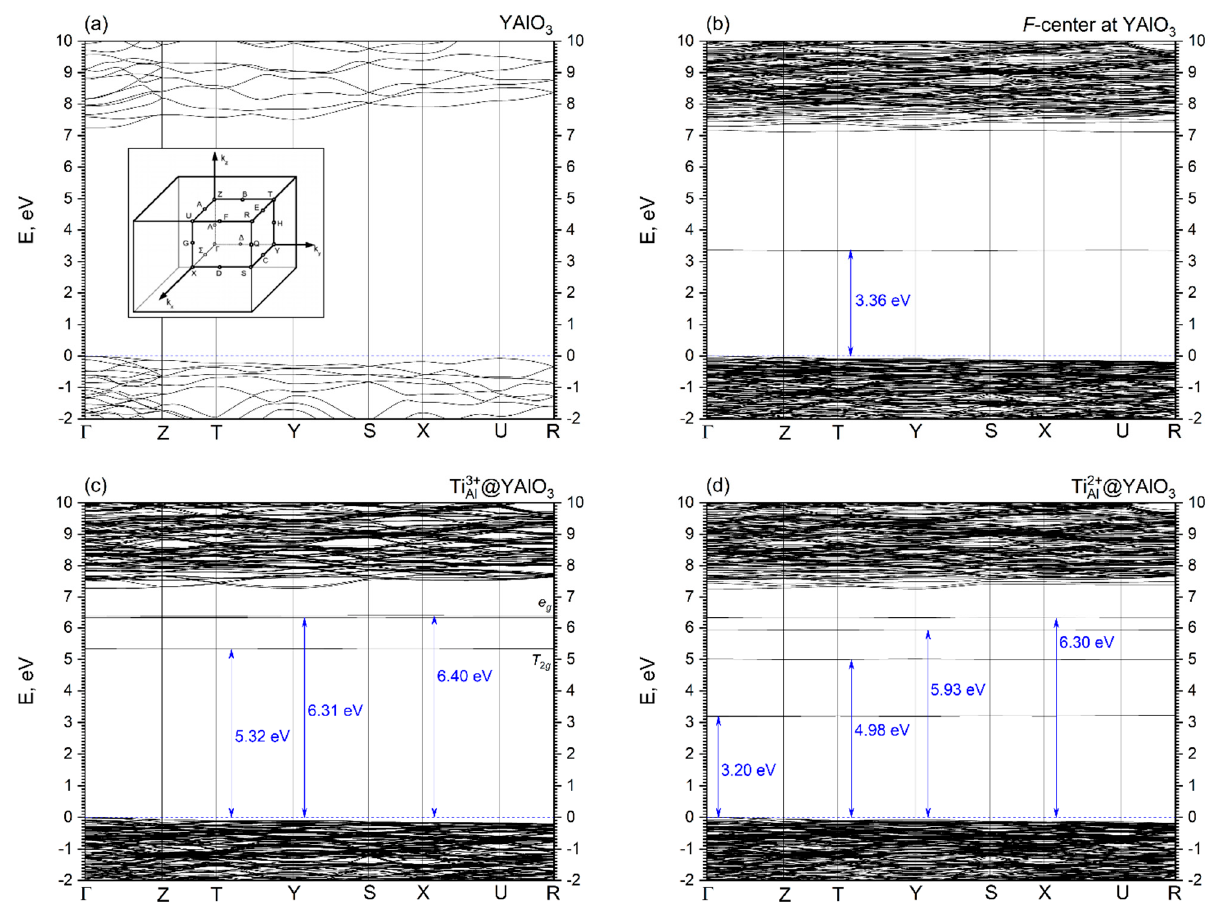
Figure 3. Electronic band structure as calculated for ( a ) perfect orthorhombic YAlO 3 bulk crystal, ( b ) F -center and YAlO 3 , ( c ) Al-site Ti 3+ -doped YAlO 3 and ( d ) Al-site Ti 2+ -doped YAlO 3 . Zero at the energy scale corresponds to the top of the valence band. Inset shows schematically the Brillouin zone and high symmetry points of Pbnm space group.